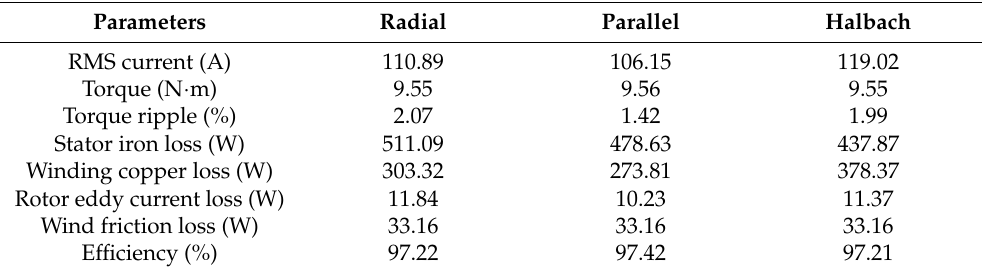
Table 5. Performances of the three HSPMMs with different PM magnetization methods under full − load condition.